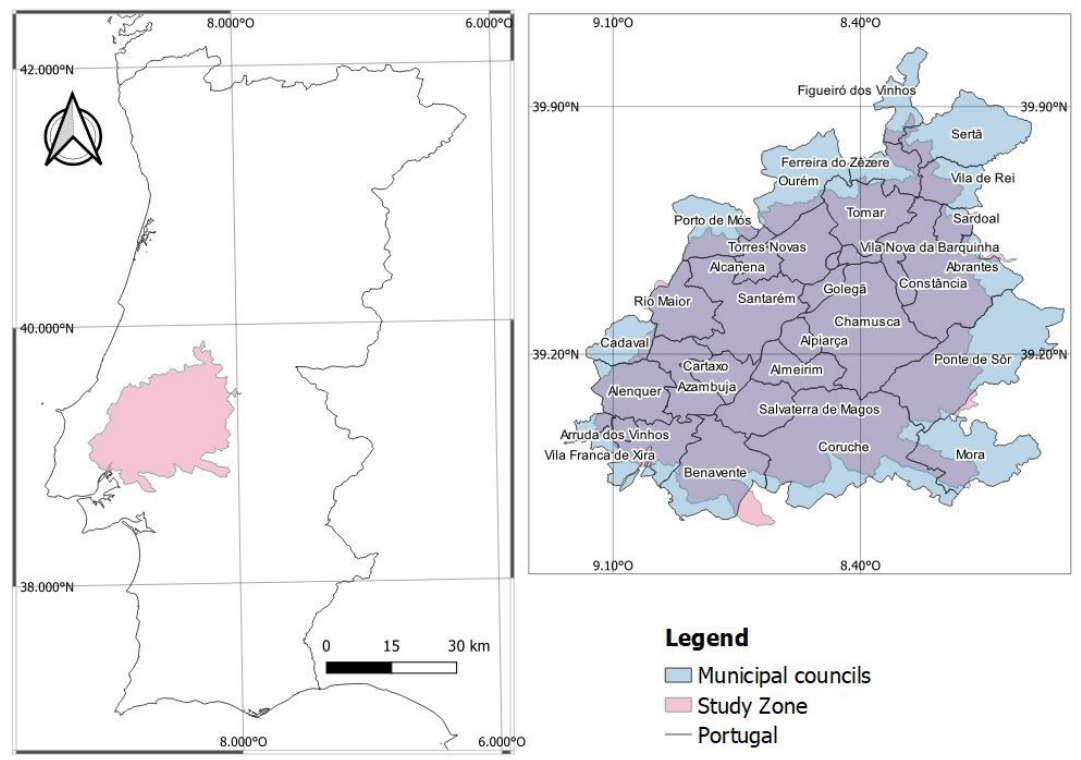
Figure 1. Geographical location and specification of the study